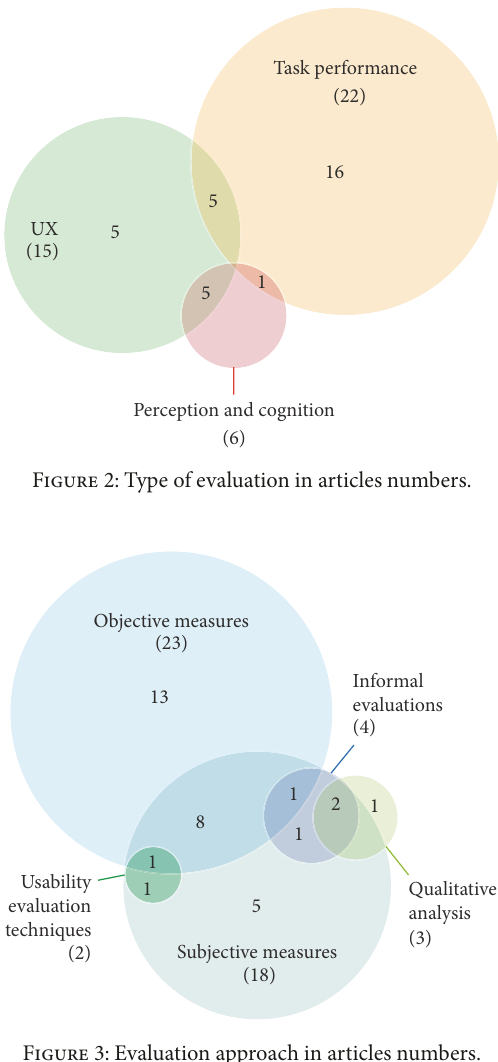
Figure 3: Evaluation approach in articles